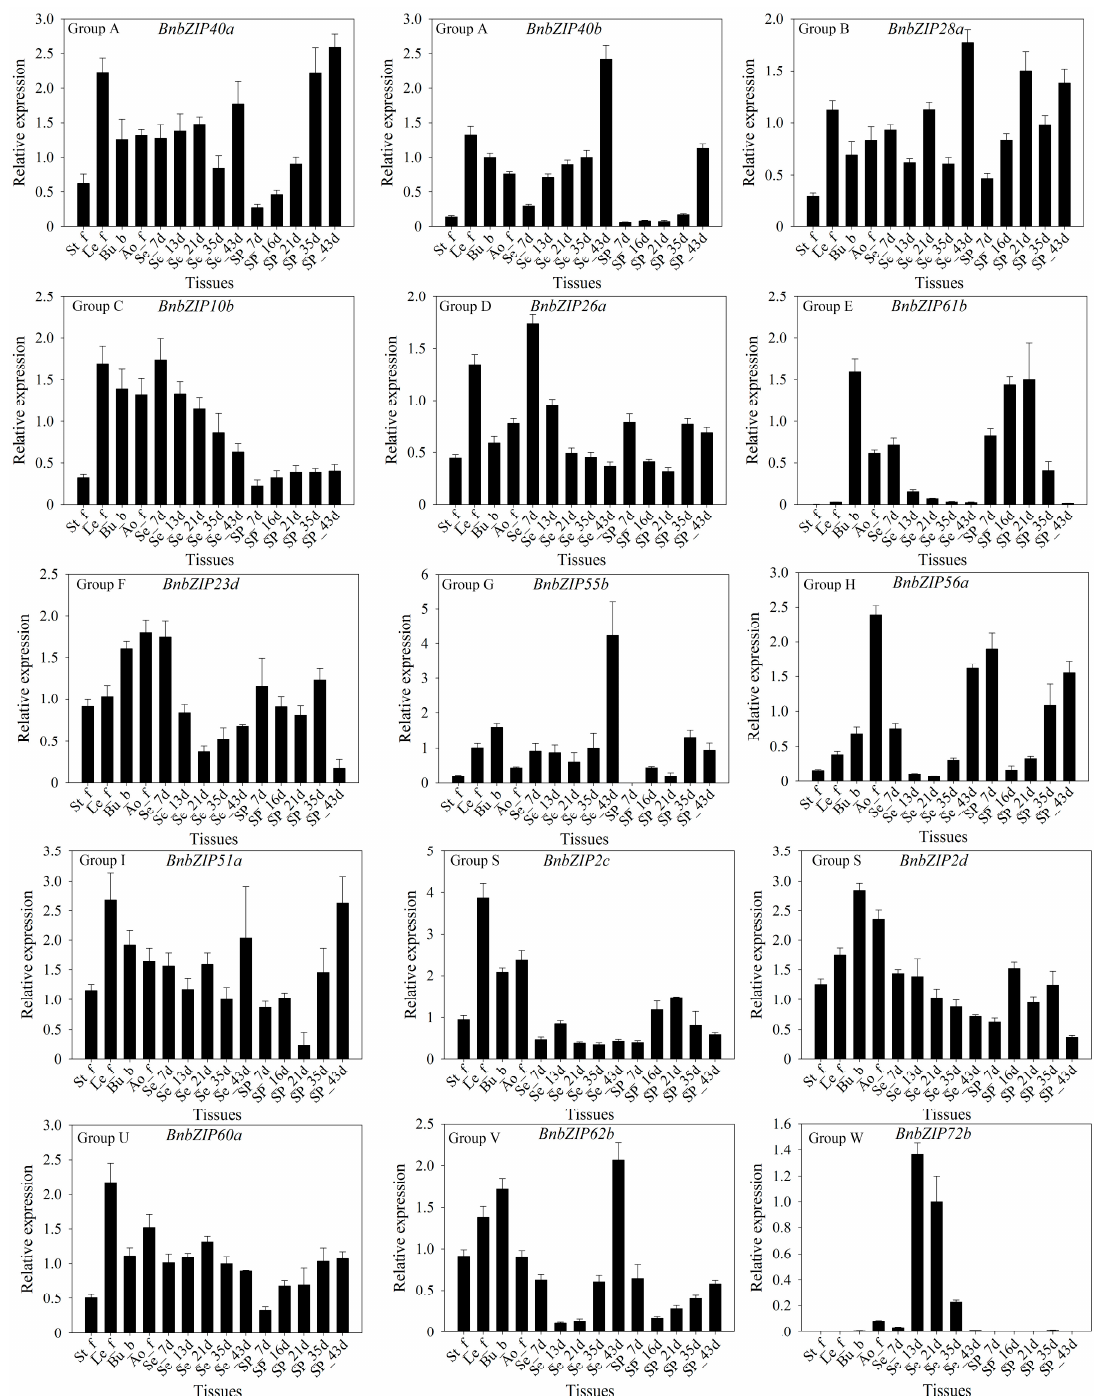
Figure 6. The expression levels of B . napus bZIP transcription factor family genes at different developmental stages in different tissues and organs, as determined by quantitative real time PCR (qRT-PCR). The subfamily is indicated in the upper-left corner of each graph. The x axis corresponds to the different tissues and organs/developmental stages of B . napus ZS11 (listed in Table S3). BnACTIN7 (EV116054) and BnUBC21 (EV086936) were used as the reference gene [41]. Values represent the average ± standard deviation (SD) of three biological replicates with three technical replicates at each developmental stage. Error bars denote SD among three experiments.